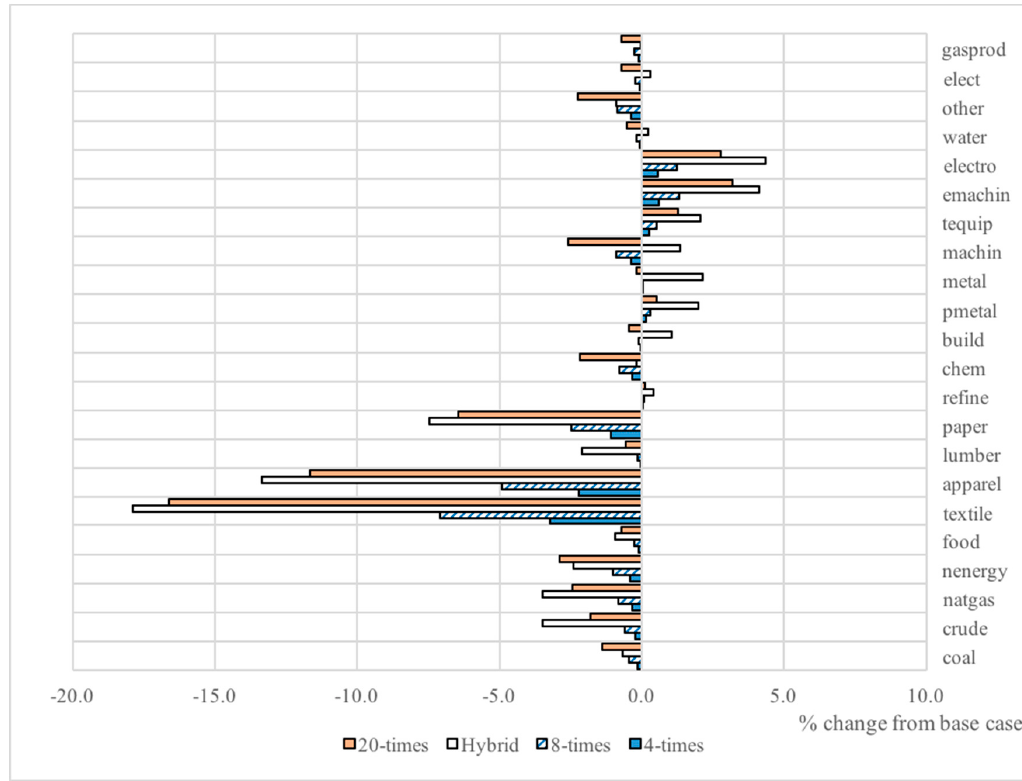
Figure 6. The impacts on COD discharge of 22 industrial sectors in 2030 (percent change). Negative values in the discharge change mean that the total COD discharge in the policy case is less than the total discharge in the baseline.